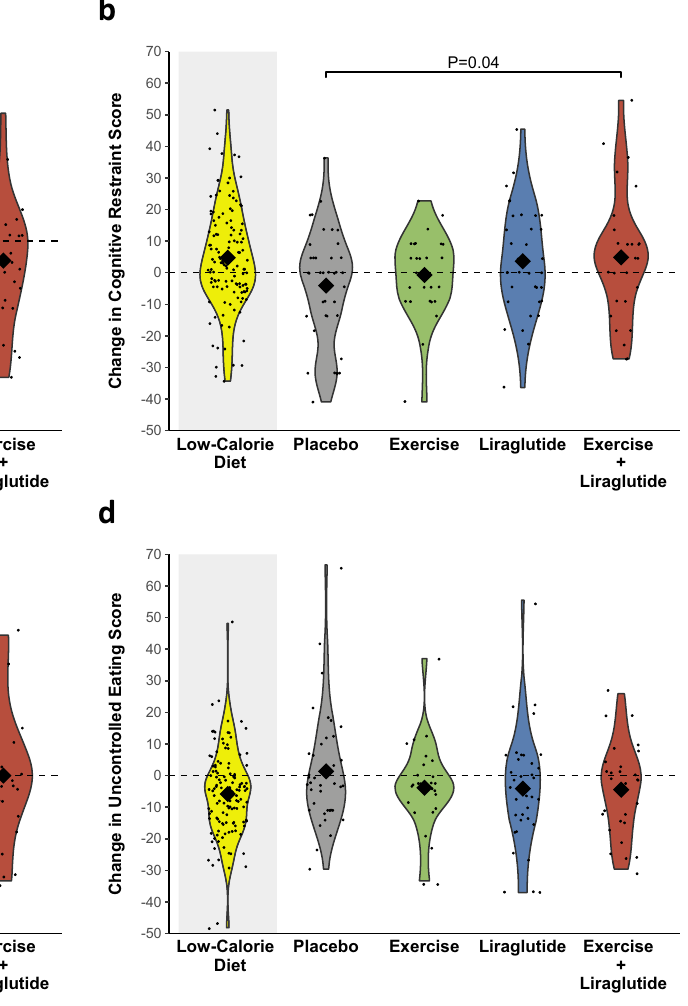
R18. Results are presented for study participants who adhered to the study inter- ventions (per protocol population). P -values are provided for signi fi cant ( P <0.05) differences from the placebo group. P-values are two-sided and unadjusted for multiple comparisons and derived from a mixed model analysis as described in statistical analyses . Source data are provided as a Source Data fi